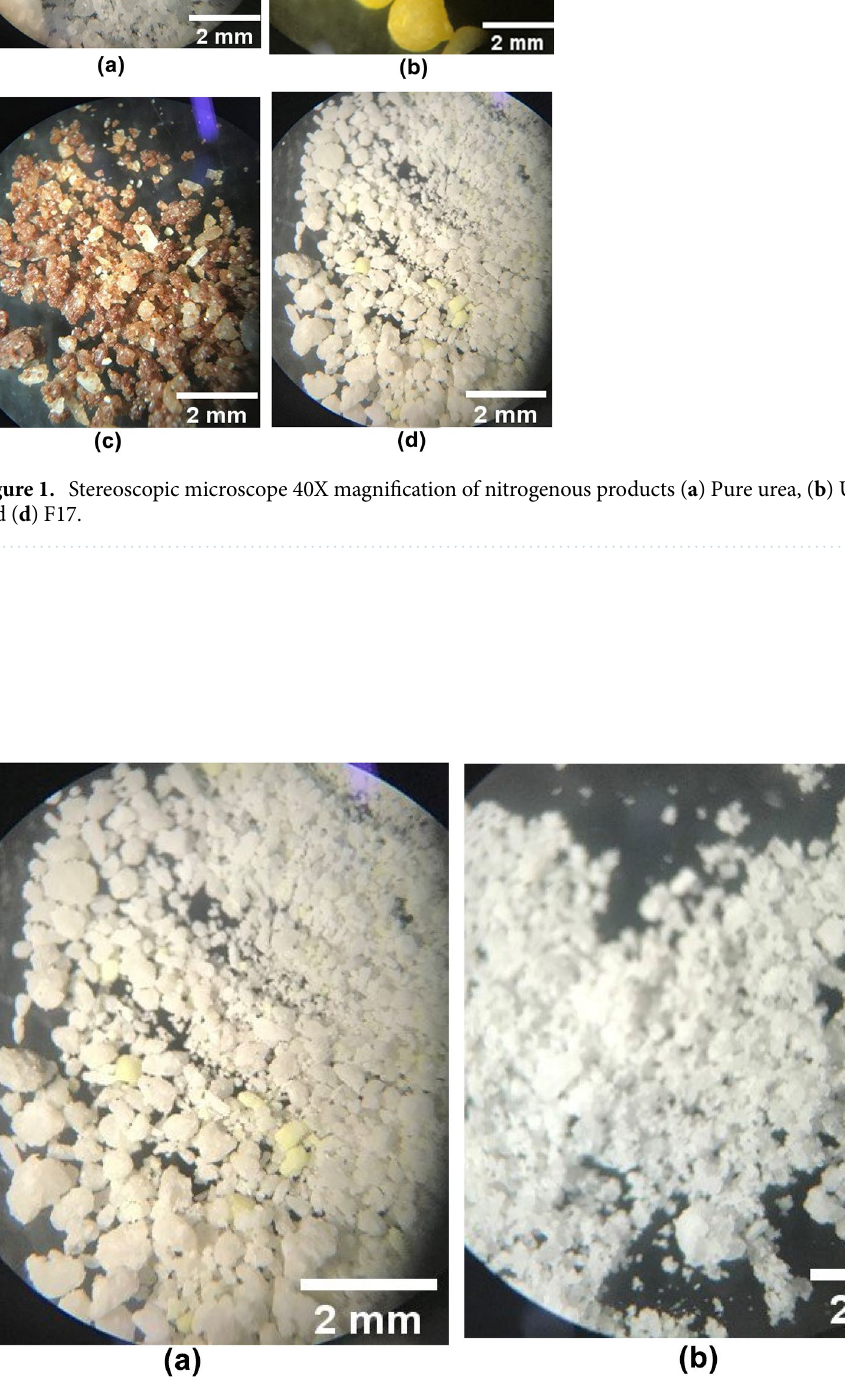
Figure 2. ( a ) F17 complete formulation e ( b ) F17 sulfur-free